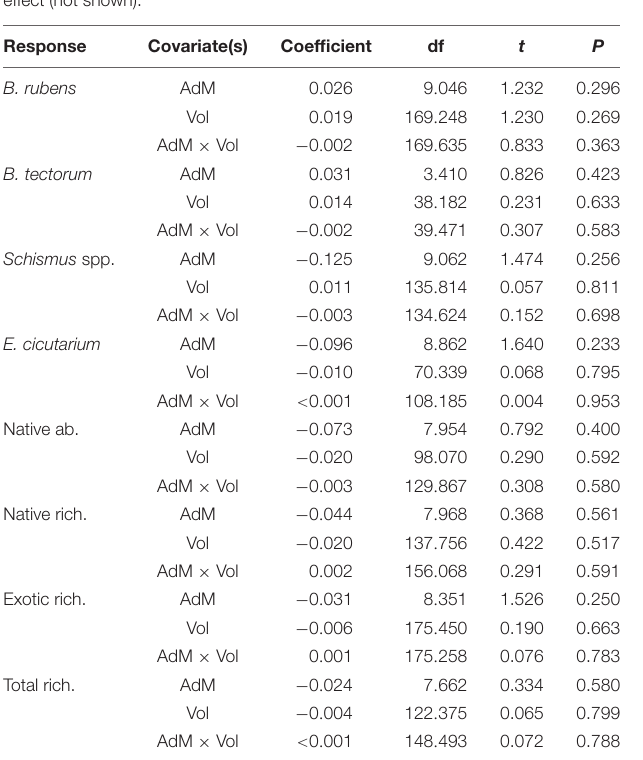
FIGURE 2 | Native abundance and native species richness (all native species combined) plotted against B. rubens abundance in shrub and open microsites. Red regression lines ( ± 95% CI) indicate significant native- B. rubens